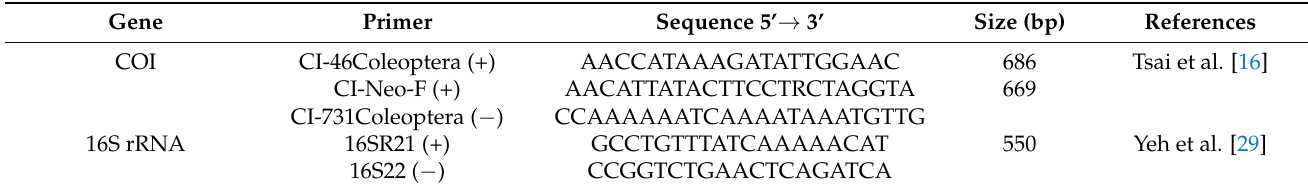
Table 2. Primers and amplification sizes for each gene in this